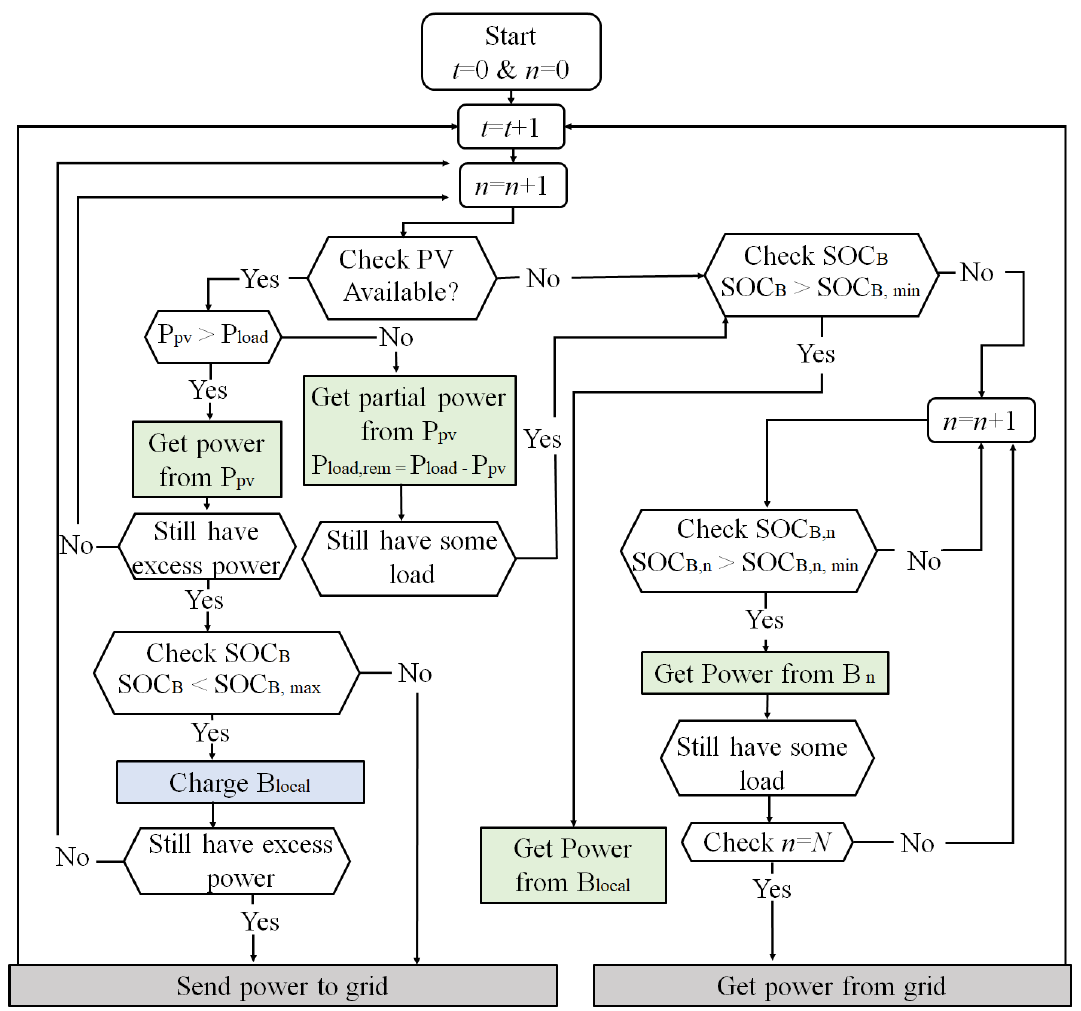
Figure 3. The steps of the heuristic state flow based energy management